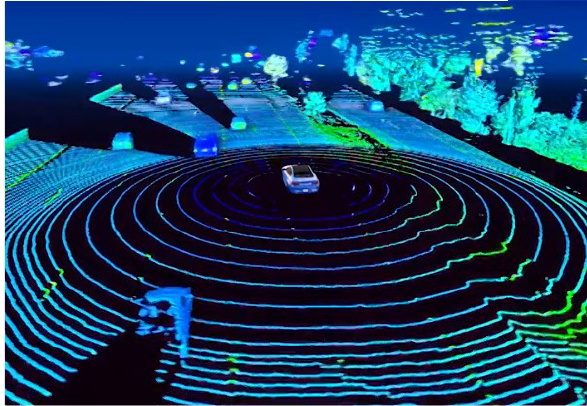
Figure 5. Panoramic LiDAR measurement in motion on the road (Velodyne Lidar, 2021).